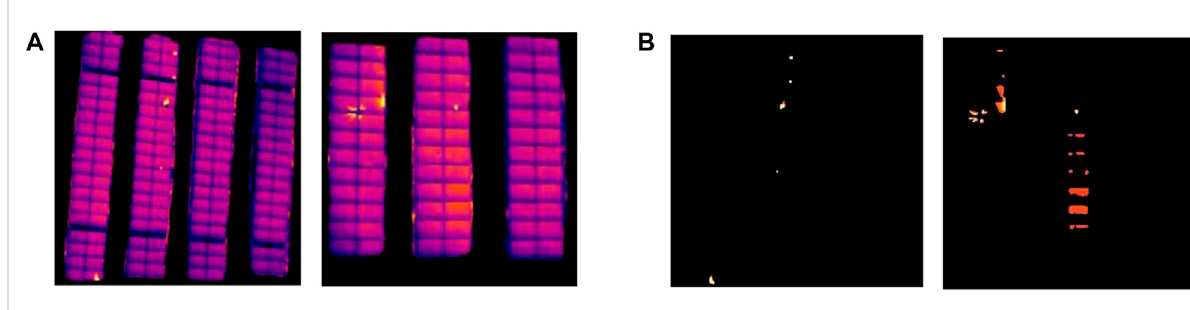
FIGURE 6 PV modules and bright spots results: (A) PV modules segmentation. (B) Bright spots segmentation.